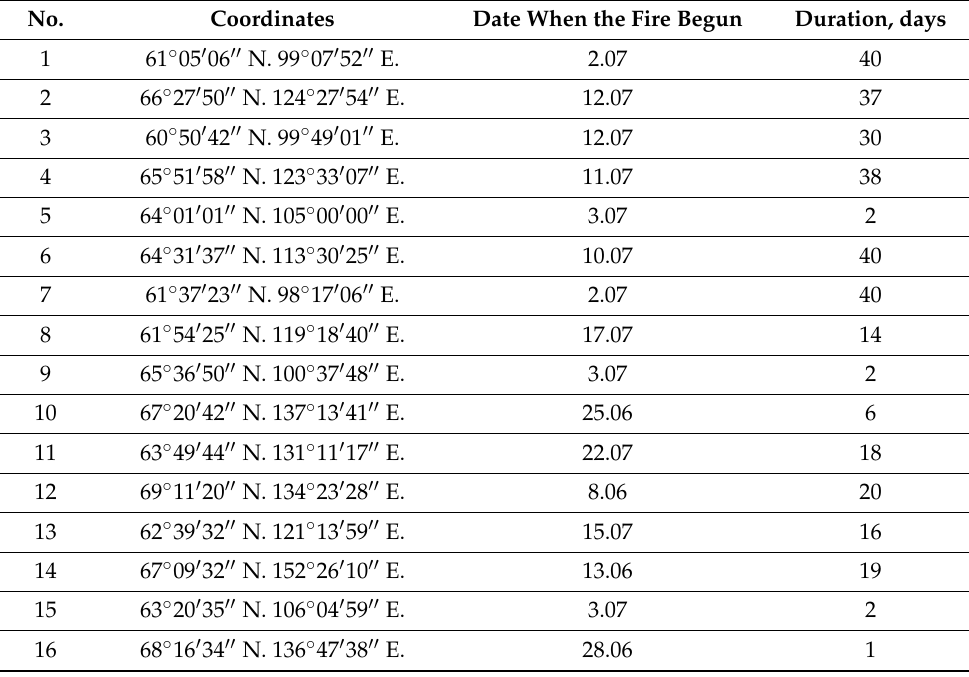
Table 2. Coordinates, date and duration of the most powerful fires in the summer of 2019. No. Coordinates Date When the Fire